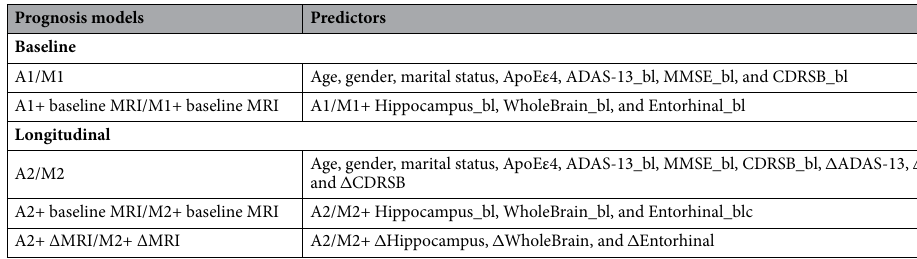
Table 4. The prognosis models and the corresponding predictors for ADAS-13 (N = 110) and MMSE (N = 92) predictive dataset. A1, ADAS-13 baseline Prognosis Model; A2, ADAS-13 longitudinal Prognosis Model; M1, MMSE baseline Prognosis Model; M2, MMSE longitudinal Prognosis Model; ADAS-13_bl, Alzheimer Disease Assessment Scale Cognitive 13 items at Baseline; MMSE_bl, Mini mental state examination at